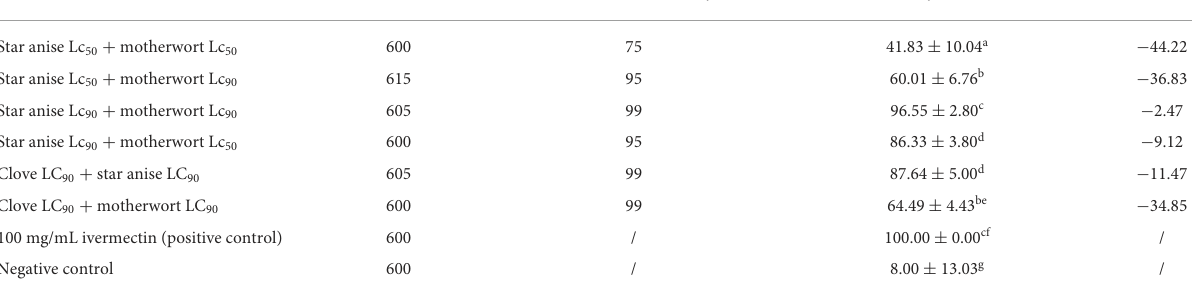
TABLE 4 Synergetic toxicity index (c · f value) of herbal alcohol extracts from Chinese herbal medicines against adult Dermanyssus gallinae A .